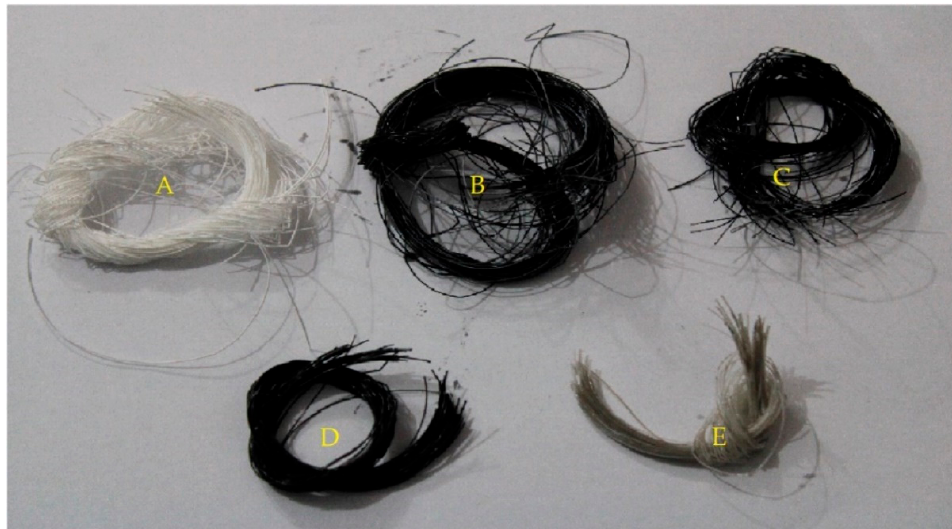
Figure 2. The aspect of the composite nanoparticles–polymer membranes (Os np –PM): A —polypro- Figure pylene hollow fiber membranes support (PP); B —Os–PPM i from OsO 4 – i -propanol–10–undecenoic acid; C —Os–PPM t from OsO 4 – t -butanol–10–undecenoic acid; D —Os–PPM n from OsO 4 – n -decanol– 10–undecenoic acid; E —Os–PPM p from OsO 4 –pure 10–undecenoic acid.